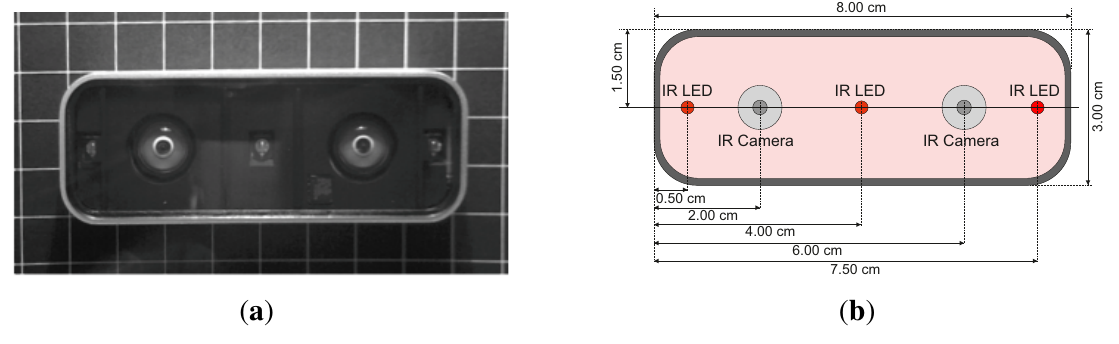
Figure 1. Visualization of a ( a ) Real (using Infrared Imaging) and ( b ) Schematic View of Leap Motion